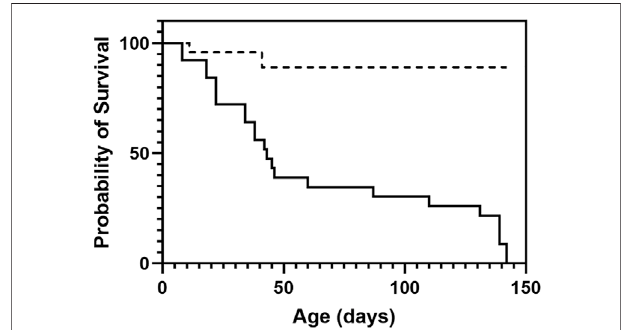
FIGURE 1 | Survival plot of Cftr Δ 9/ Δ 9 mice. At time of weaning (21 days) Cftr Δ 9/ Δ 9 mice had a survival of 83% which dropped to 38% by day 50, with most mice succumbing to intestinal obstruction or malnutrition (solid line). Heterozygousmicedidnotshowdecreasedsurvivalwith89%survivalat day 50 until day 150 when monitoring ended (dashed line). n =